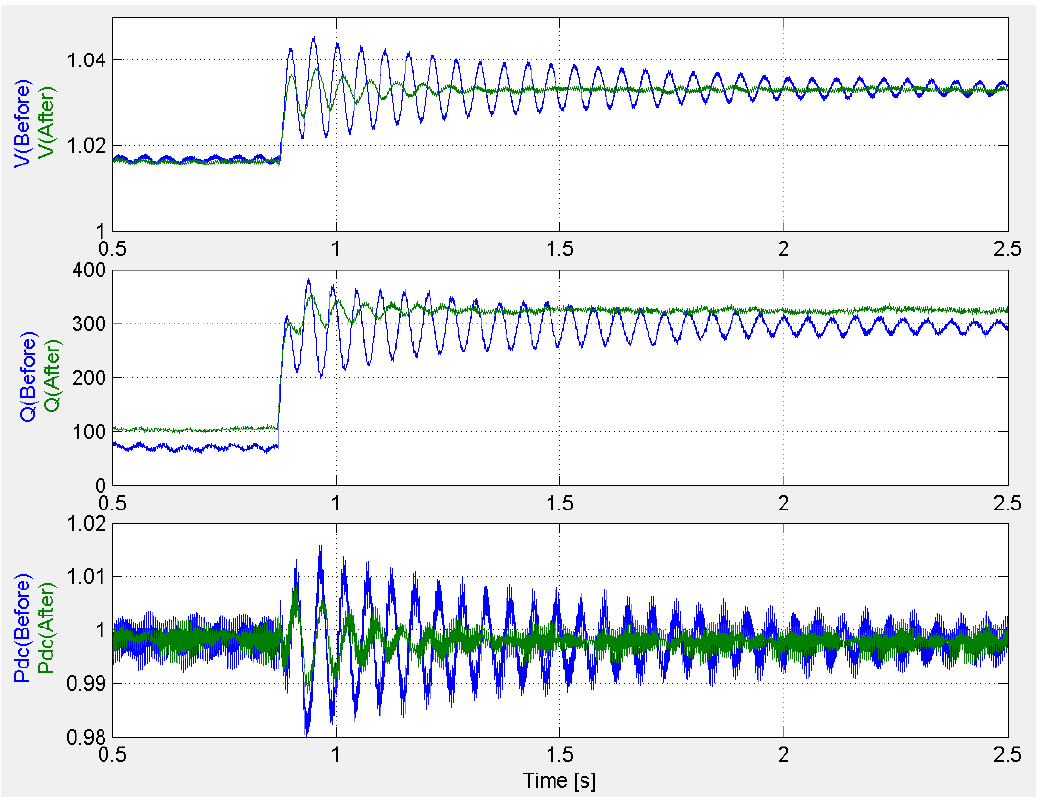
Figure 3. An example of parameter tuning experience during HILS-DPT; step-response test; voltage (first row), reactive power of STATCOM (second row), and active power of high-voltage direct current (HVDC; third row); before tuning (blue line) and after tuning (green line).